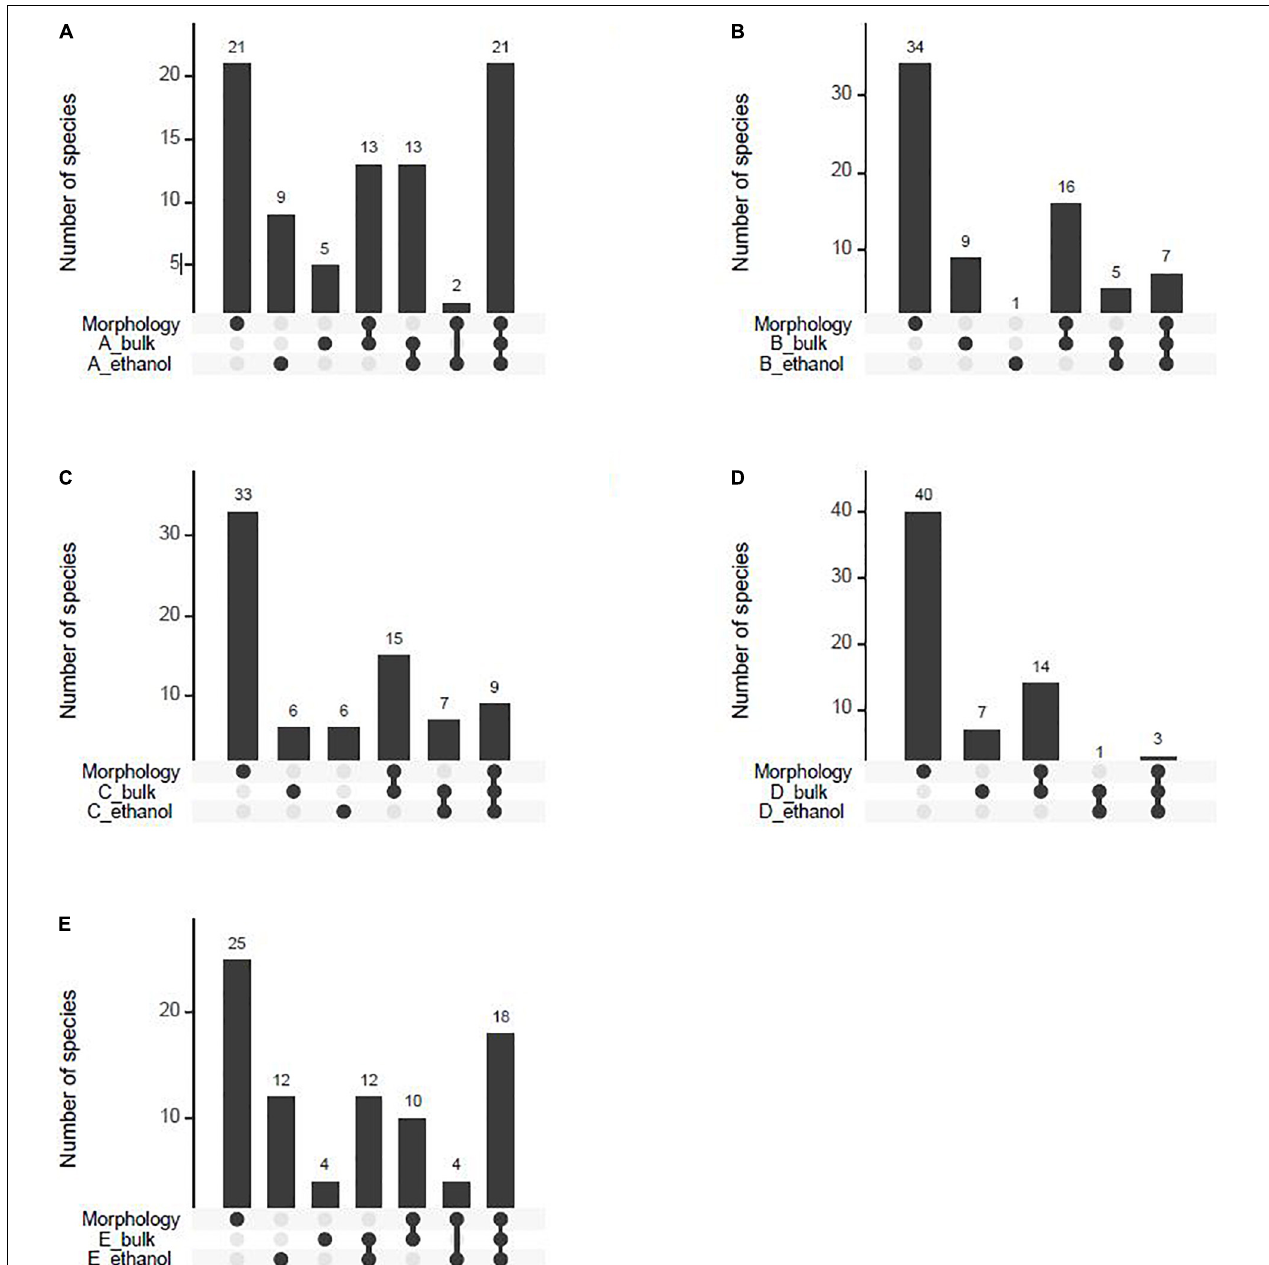
FIGURE 3 | The number of unique and shared species between morphological, bulk DNA and eDNA from the ethanol preservative datasets for each of the five primer sets (A–E) . Datasets are based on the four samples that were identified morphologically to allow a one-on-one comparison. Black dots indicate in which dataset the species represented by the black bar were